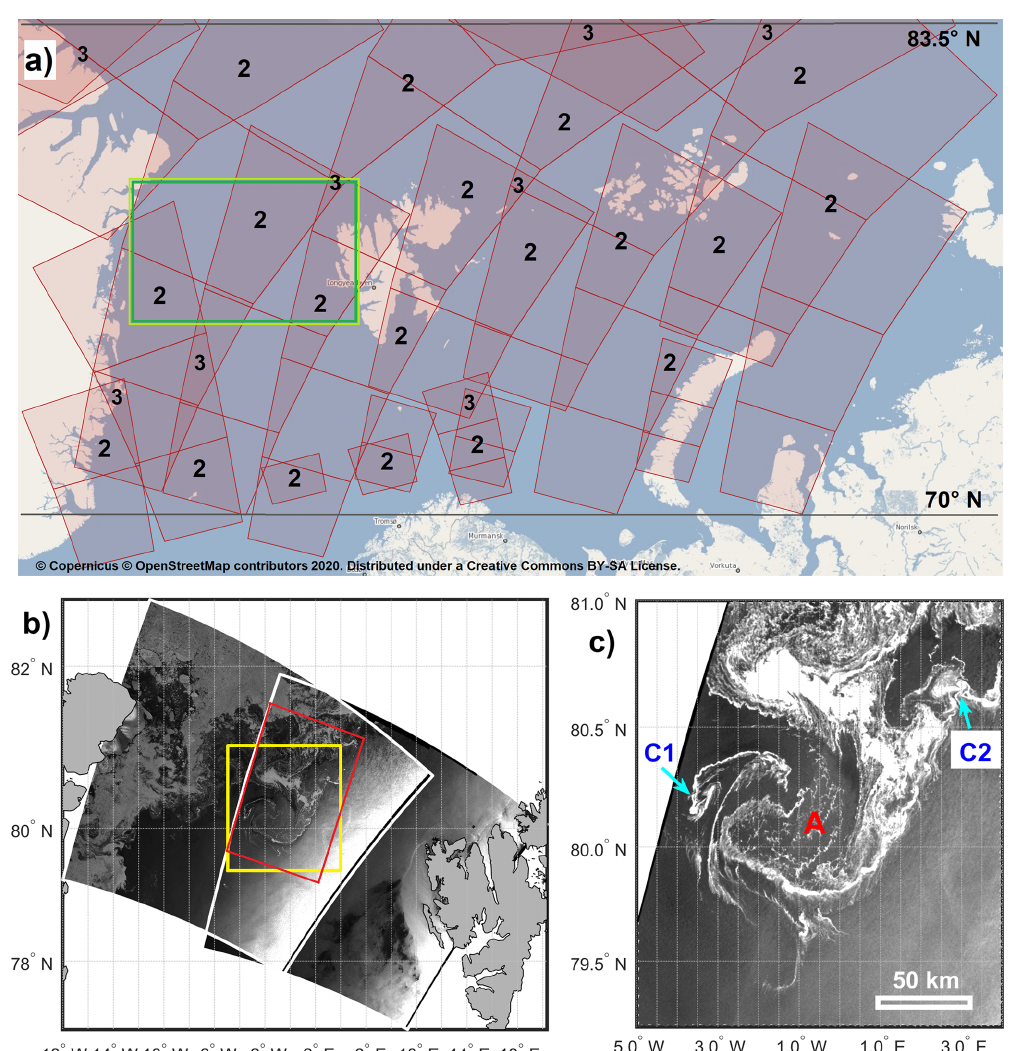
Figure 1. (a) Map of the European Arctic showing the coverage of Sentinel-1A/B SAR image acquisitions available on 17 September 2017. Pink frames mark the borders of individual SAR images, while digits show the number of overlapping SAR frames. Grey lines mark latitude boundaries of 70 ◦ N and 83.5 ◦ N. The green box shows the area of Fram Strait. The map is taken from Copernicus Open Access Hub © Copernicus © OpenStreetMap 2020. Distributed under a Creative Commons BY-SA License. (b) Position of two sequential Sentinel-1A/B images acquired on 17 September 2017 over Fram Strait. Red and yellow frames mark the regions enlarged in (c) and in Fig. 2a. (c) Enlarged fragment of Sentinel-1A image for the same date (07:12UTC) with distinct signatures of a large anticyclone and several cyclones in the marginal ice zone. Letters A, C1, and C2 mark eddies described in the